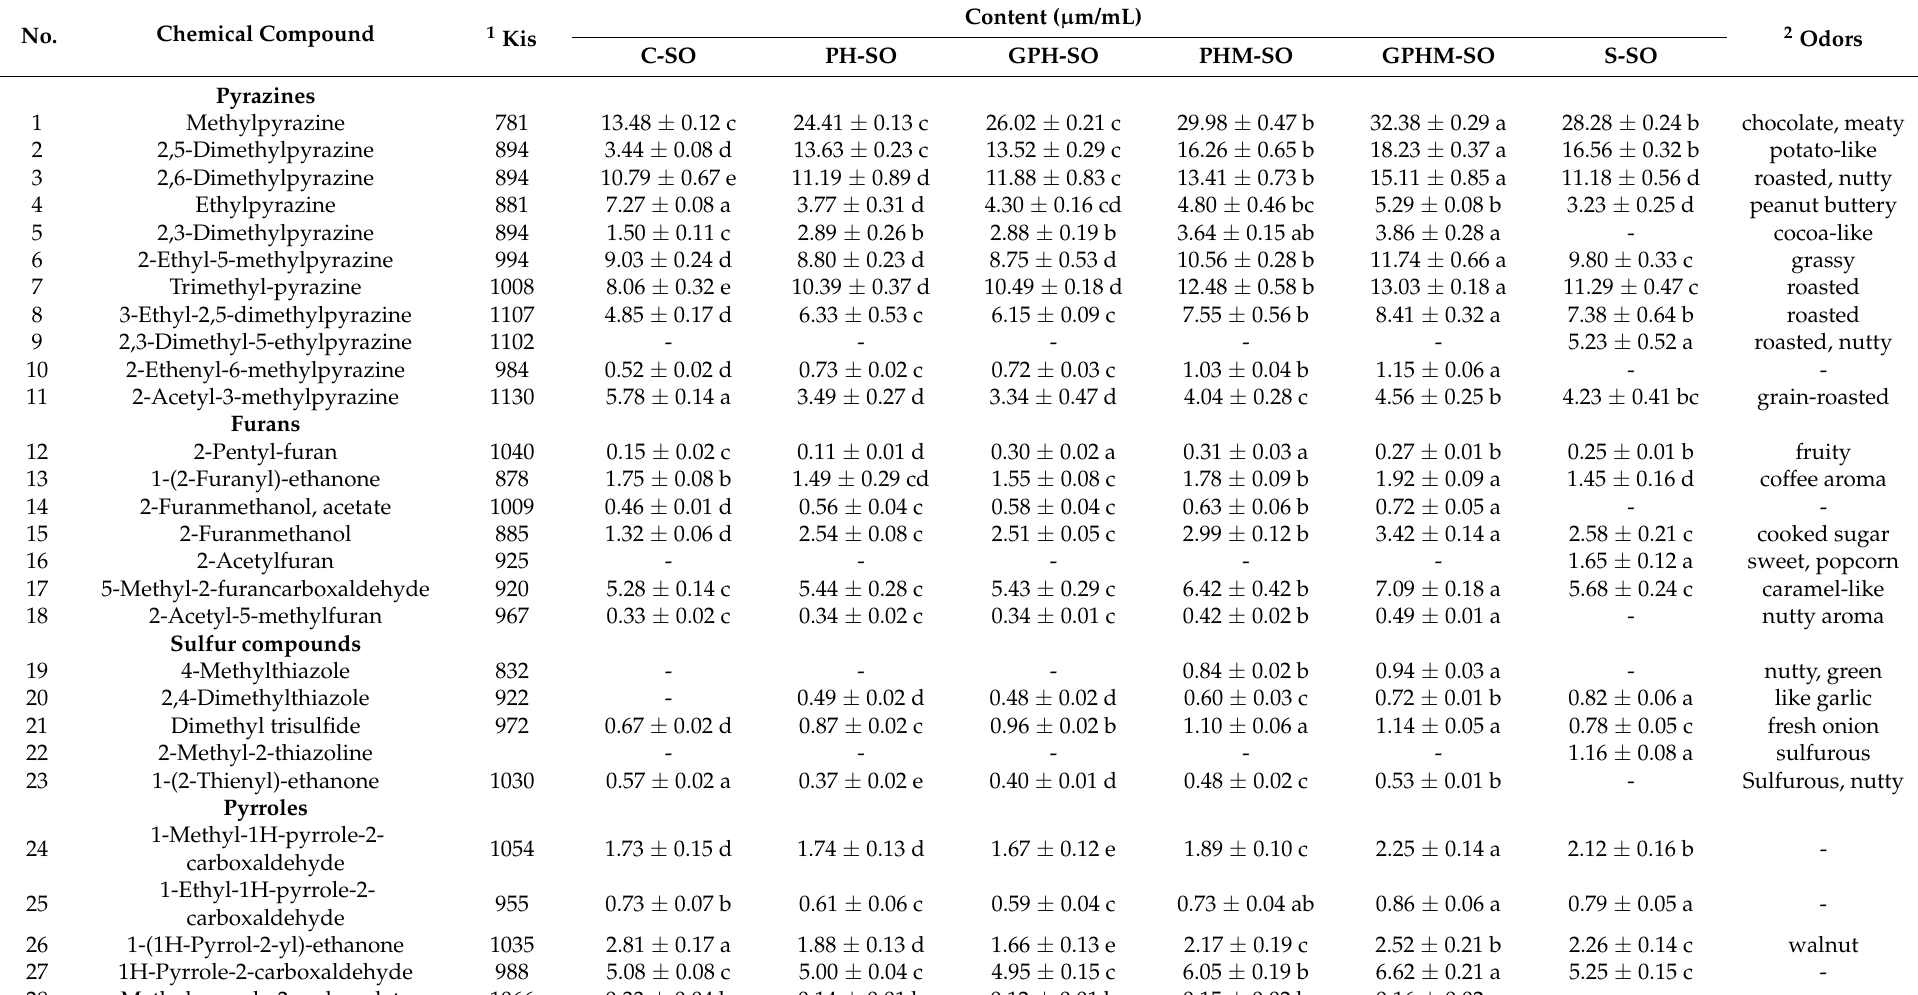
Table 4. Comparison of volatile organic compound content of sesame oil with different treatments and sold sesame